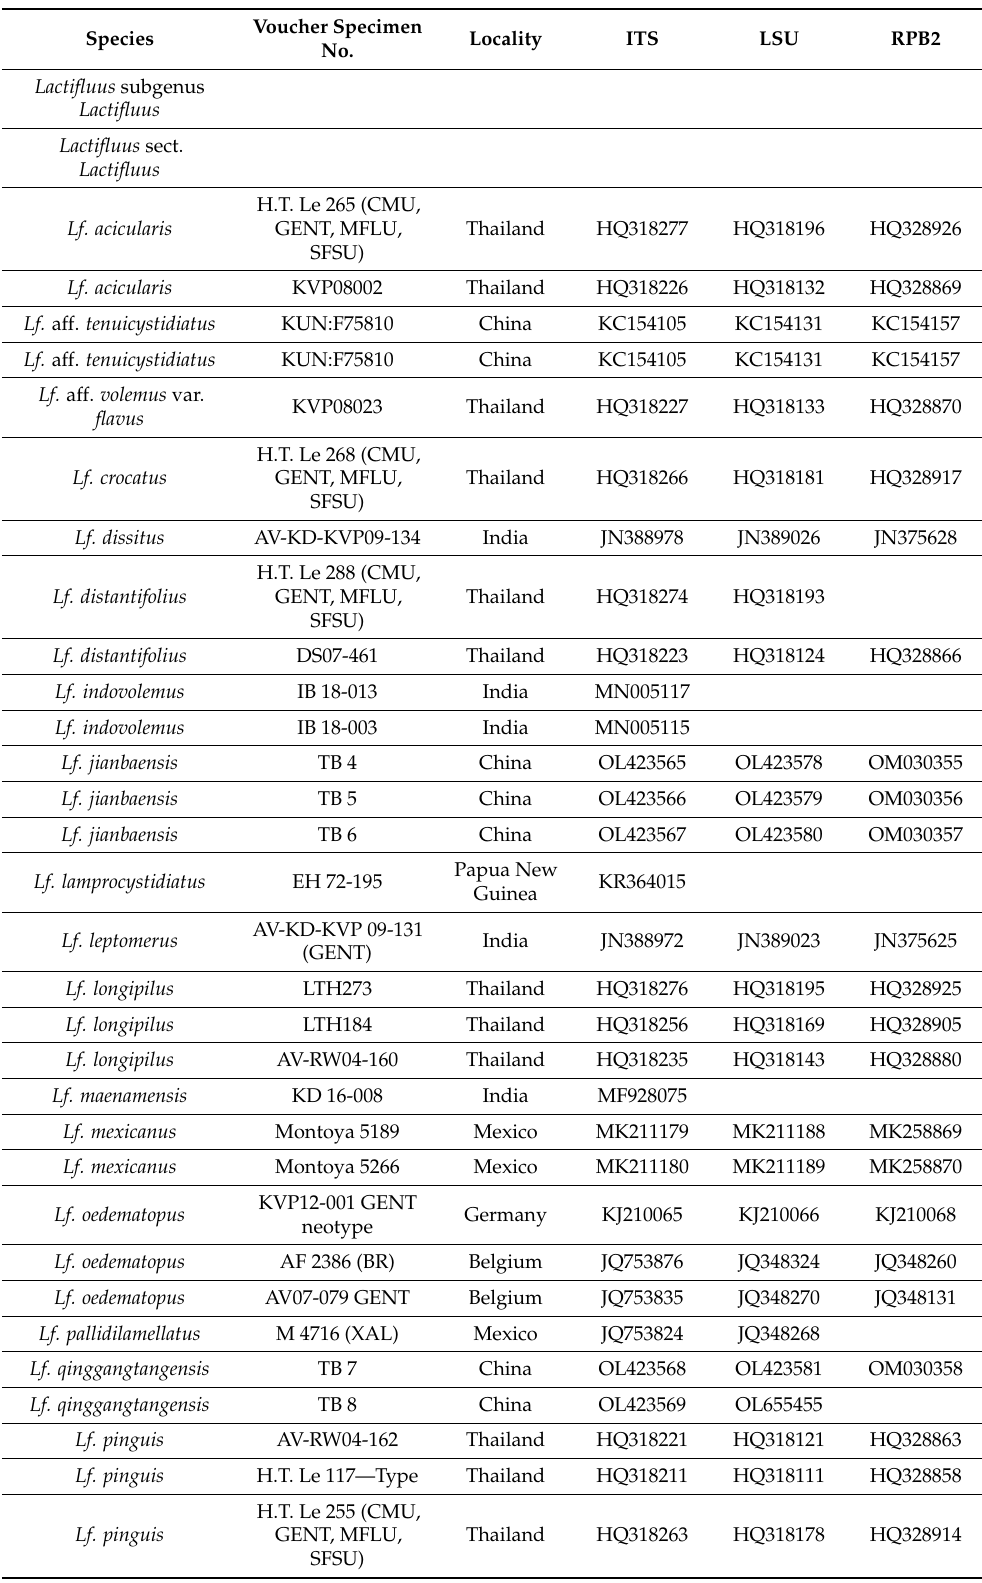
Table 1. Specimen and GenBank accession numbers of DNA sequences used in the molecular analyses. The arrangement of the subgenera and sections in the table follows their position in the concatenated phylogeny of the genus Lactifluus subgenus Lactifluus (Figure 1). Voucher Specimen Species